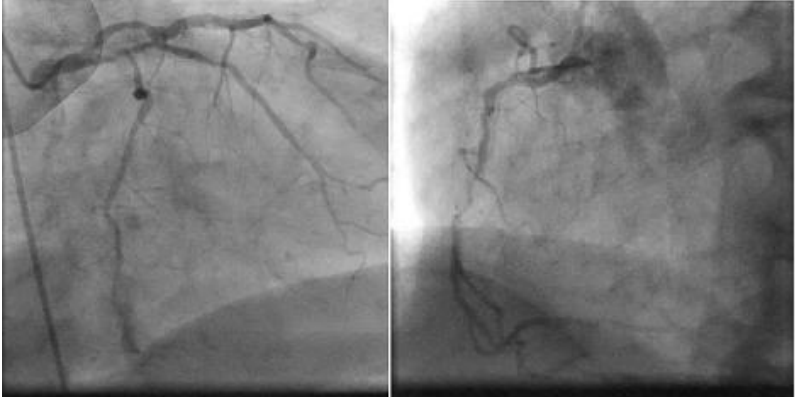
Figure 1. (left) The left anterior descending (LAD) artery was a large, heavily calcified vessel which gave rise to a small 1 st diagonal from its proximal portion and a small 2 mm 2 nd diagonal from its mid portion before it wrapped around the apex. The LAD had 70% stenosis in the proximal portion before takeoff of the 1 st septal perforated. After the 2 nd diagonal, the mid-to-distal LAD had 2 sequential 60% stenotic areas. The left circumflex was70% stenotic with heavy calcification near the proximal portion. (Right) The right coronary artery (RCA) had 50% proximal stenosis followed by diffuse, calcified 80% stenosis of the proximal-to-mid portion of the vessel. There was 70% stenosis in the posterior descending artery